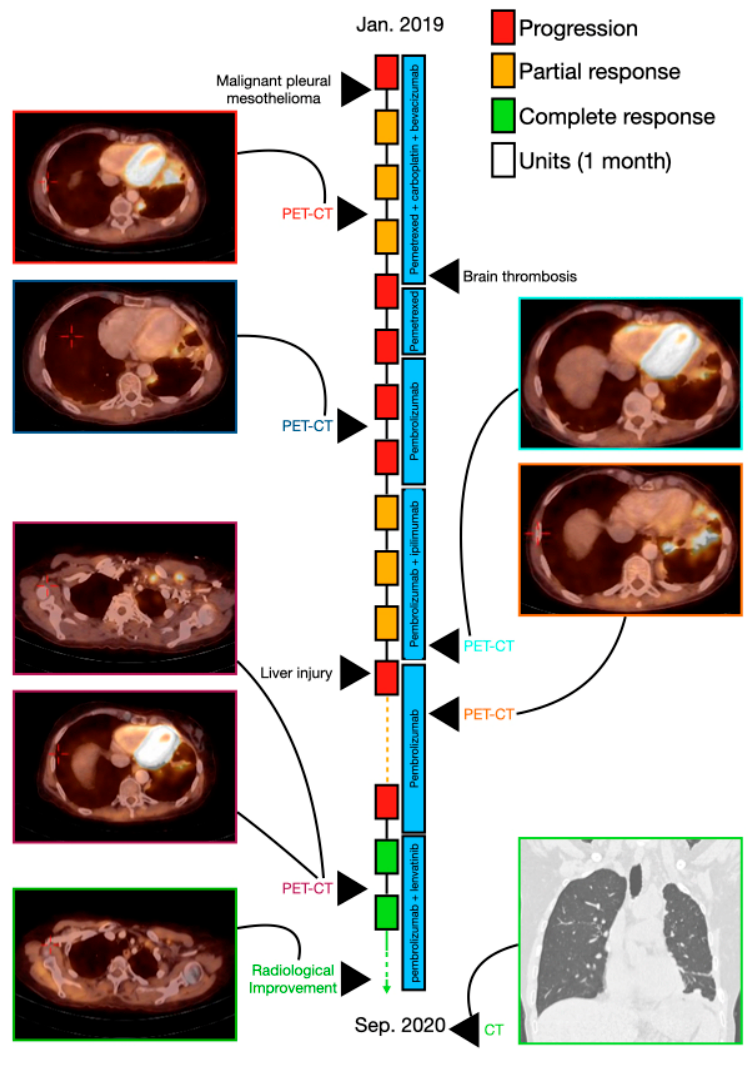
Figure 4. A schematic illustration of patient 4 ′ s timeline, between January 2019 (diagnosis of the disease) and September 2020, including the course of treatment and radiological follow ‐ up. Each rectangle represents 1 month, and the response to treatment during each month is color ‐ coded in green, red, or yellow, as described in the upper legend. Treatment administered in each timepoint is indicated by the blue rectangles. Radiological findings and additional landmarks are presented at relevant points throughout the timeline.